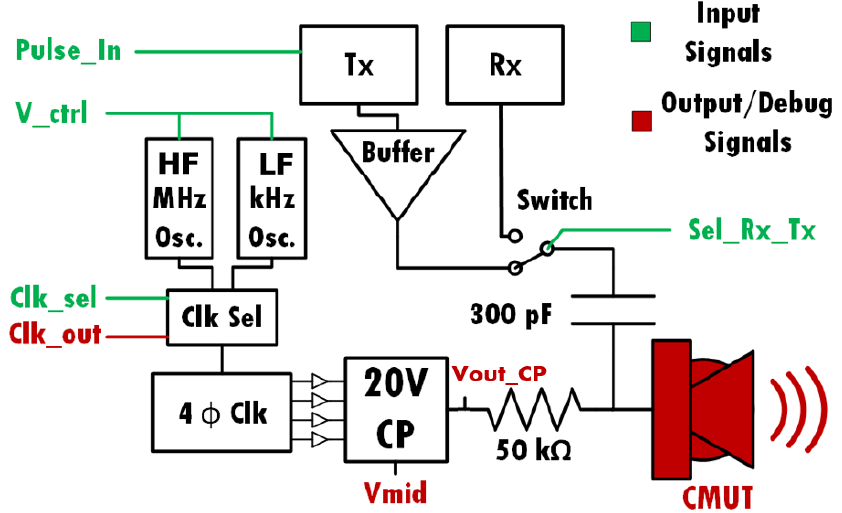
Figure 4. System diagram of the transmitter and charge pump interface.